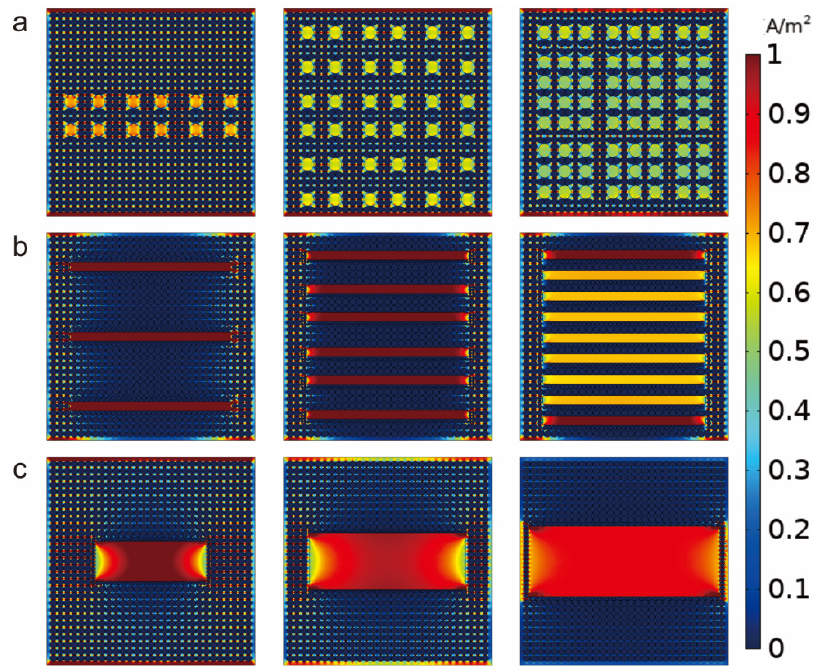
Figure 9. Electric-current density distributions of models of seafloor sulfide-bearing rocks under a horizontal electric field. ( a ) Disseminated sulfide models with various sulfide contents of 4%, 12%, and 20%. ( b ) Vein sulfide models with various sulfide contents of 10%, 20%, and 30%. ( c ) Massive sulfide models with various sulfide contents of 10%, 20%, and 30%. The red zones denote a high electric-current density, which means that more current flows through these areas.